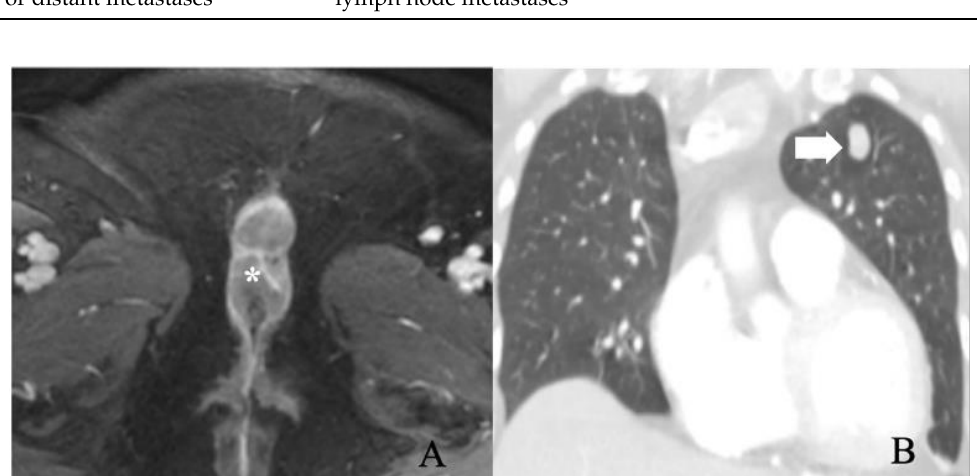
Figure 7. FIGO stage IV. A 56-year-old female with squamous cell carcinoma of the vulva. ( A ) post- contrast fat-saturated axial T1 weighted MRI image shows an enhancing 5.2 × 2.8 cm vulvar tumor ( A ) post-contrast fat-saturated axial T1 weighted MRI image shows an enhancing 5.2 × 2.8